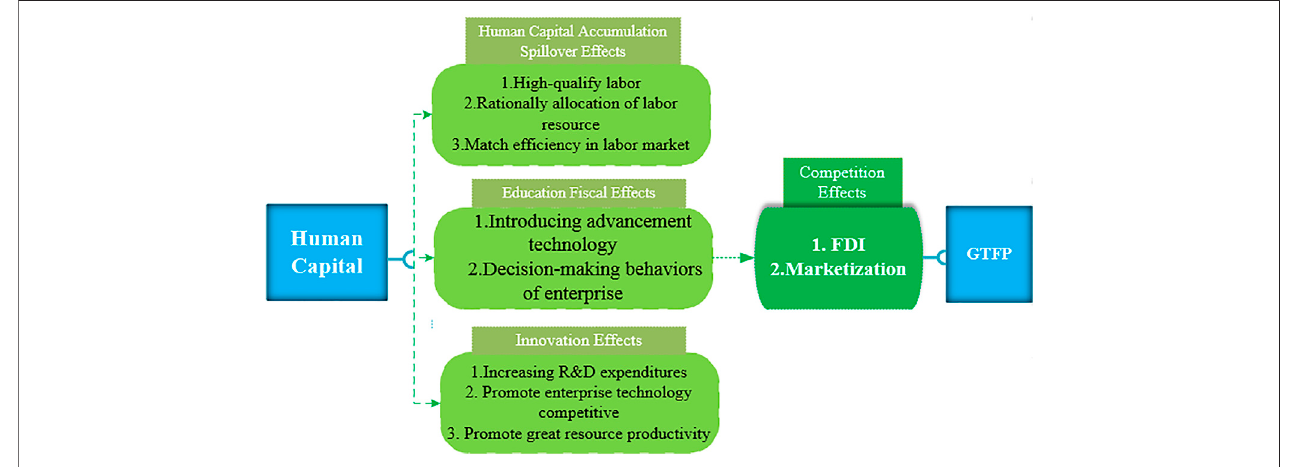
FIGURE 1 | The sustainability mechanism of human capital on